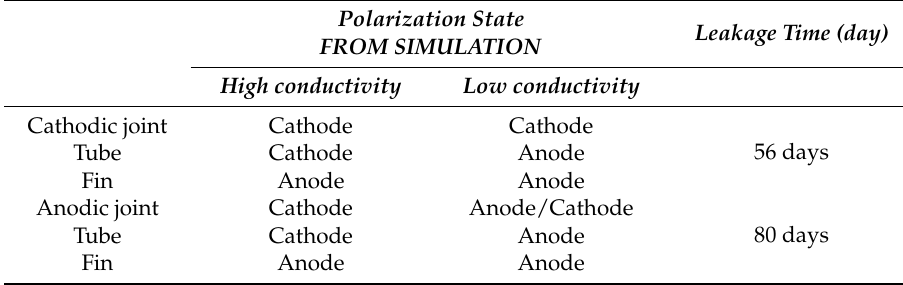
Table 3. Sea water acetic acid test (SWAAT) results and polarization states of Al fin-tube heat exchangers assembled with cathodic or anodic